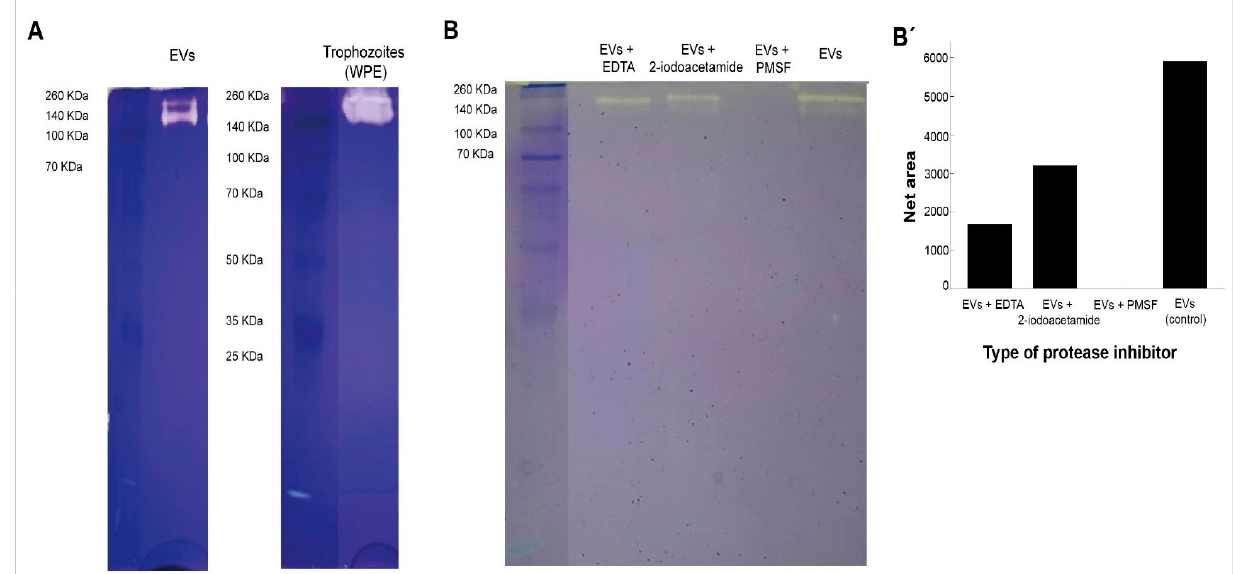
Figure 5. Protease activity of extracellular vesicles and whole protein extracts of trophozoites of Naegleria fowleri showing clear areas of gelatin digestion. For this experiments, 2.5 µ g of protein/sample were loaded onto the gel. ( A ) Protease activity of extracellular vesicles (EVs) and whole protein extracts (WPE) of trophozoites of N. fowleri . ( B ) Specific protease activity of EVs previously incubated with EDTA 10 mM (metalloproteases inhibitor), 2-iodoacetamide 1 mM (cysteine proteases inhibitor) and phenylmethylsulfonyl fluoride (PMSF) 1 mM (serine proteases inhibitor). Protease activity was fully inhibited by PMSF, which could indicate a predominance of serine proteases in the samples analyzed. Densitometry analysis of the gel was preformed using Image J software and band intensities are represented in ( B’ ).